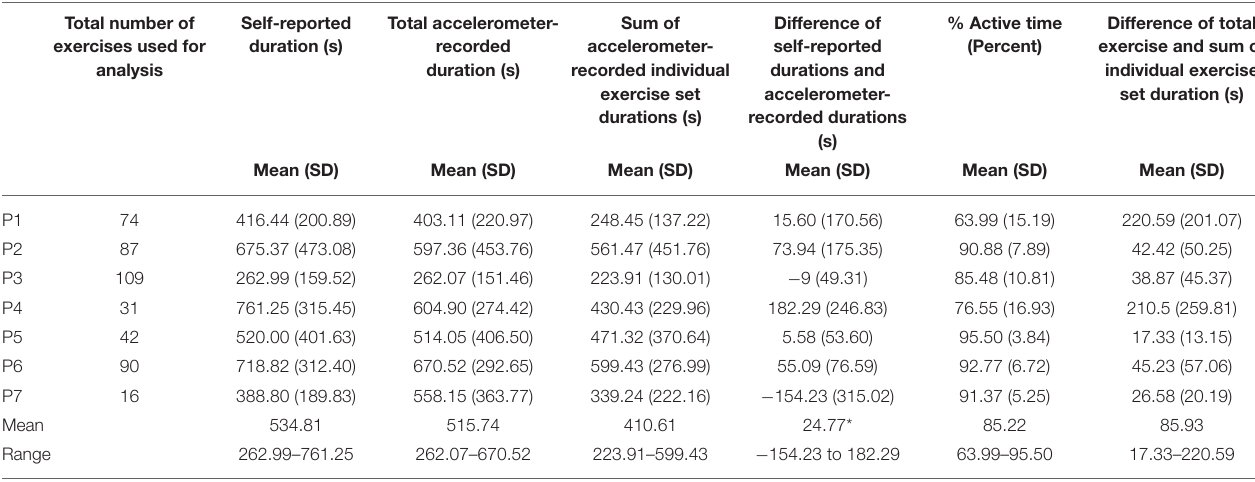
TABLE 2 | Comparison of self-report and accelerometer recorded